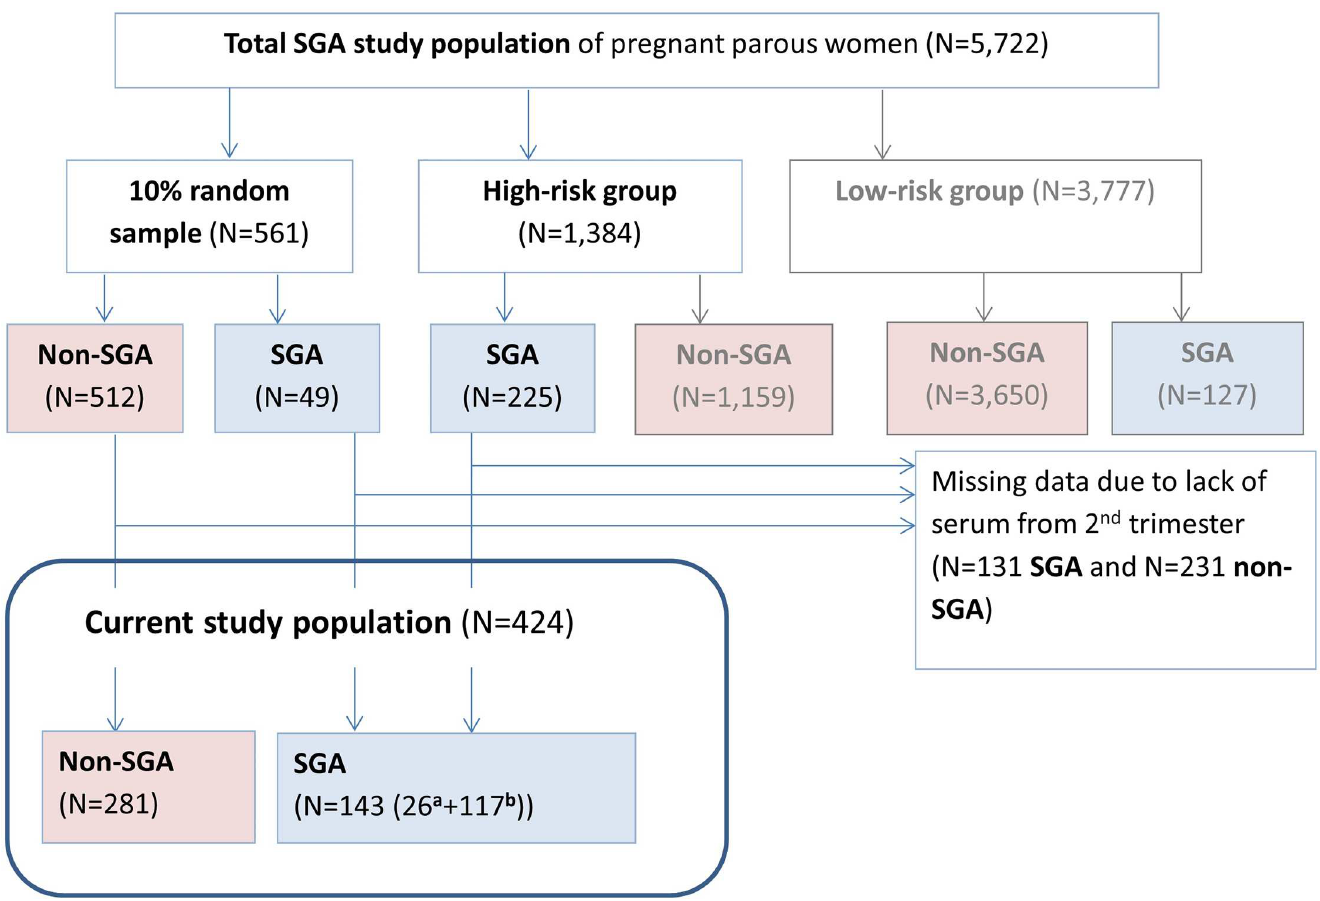
Fig 1. Flow chart of the participant selection for PFAS and OC analysis. 1 From 10% random sample. 2 From High-risk